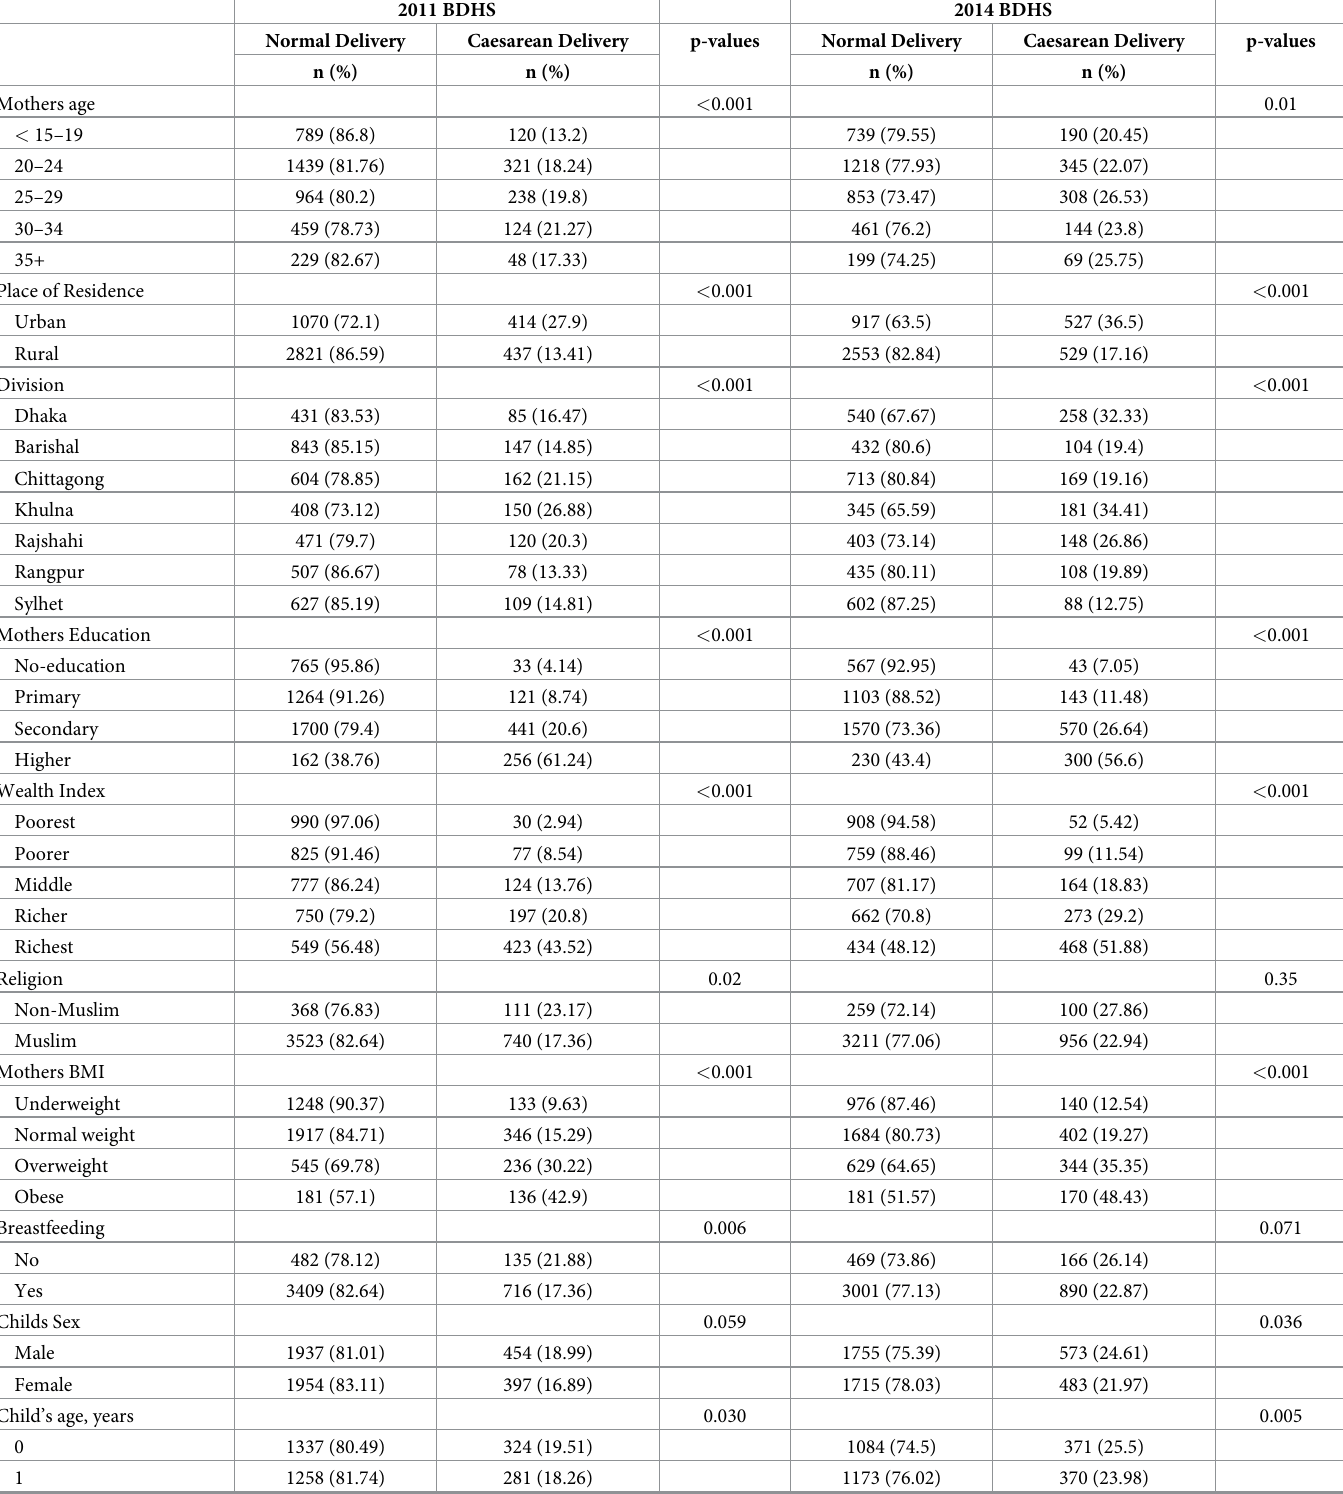
Table 1. Sample characteristics of mother and children by delivery status, BDHS